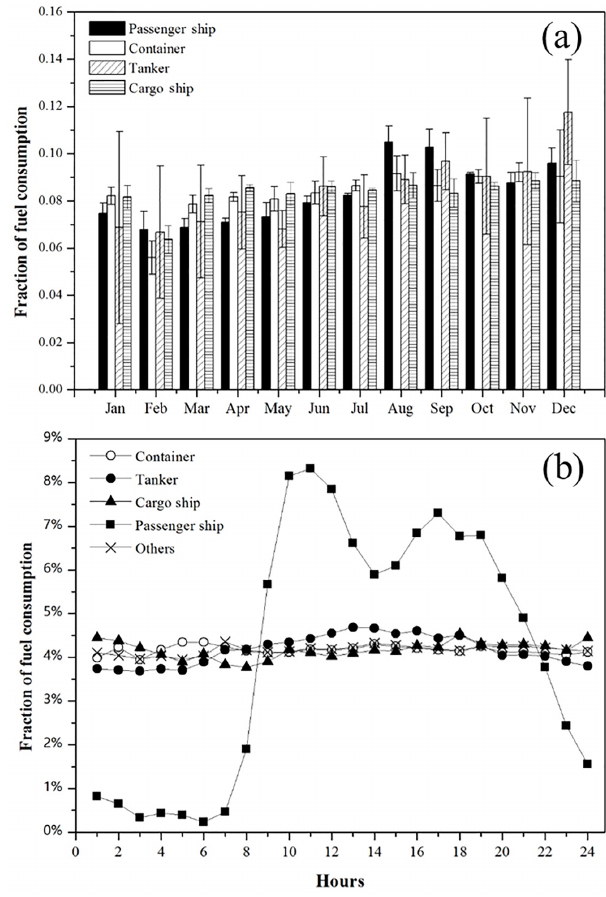
Figure 4. Monthly (a) and diurnal variations (b) in annual fuel con- sumption by vessel